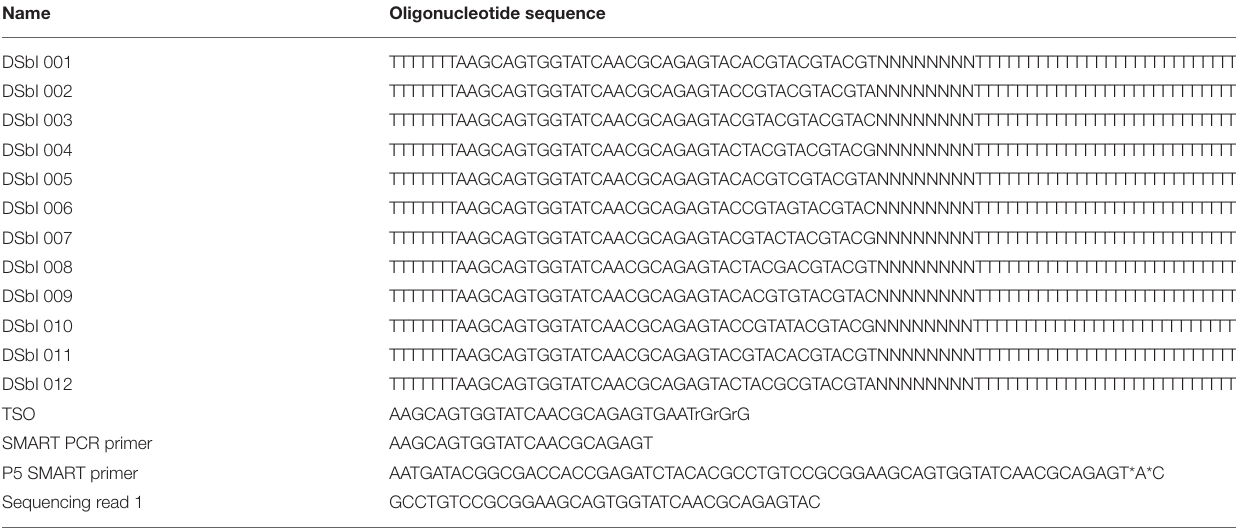
TABLE 1 | Primers used in this